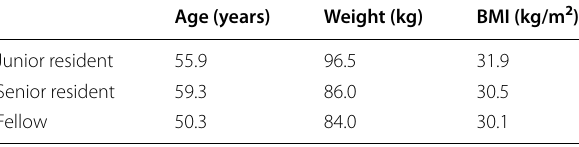
Table 3 Time in seconds to obtain cardiac